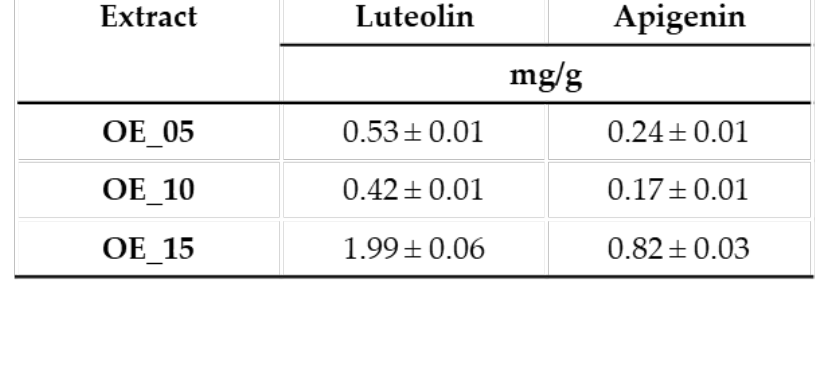
Antioxidants 2022 , 11 , x FOR PEER REVIEW 14 of 23